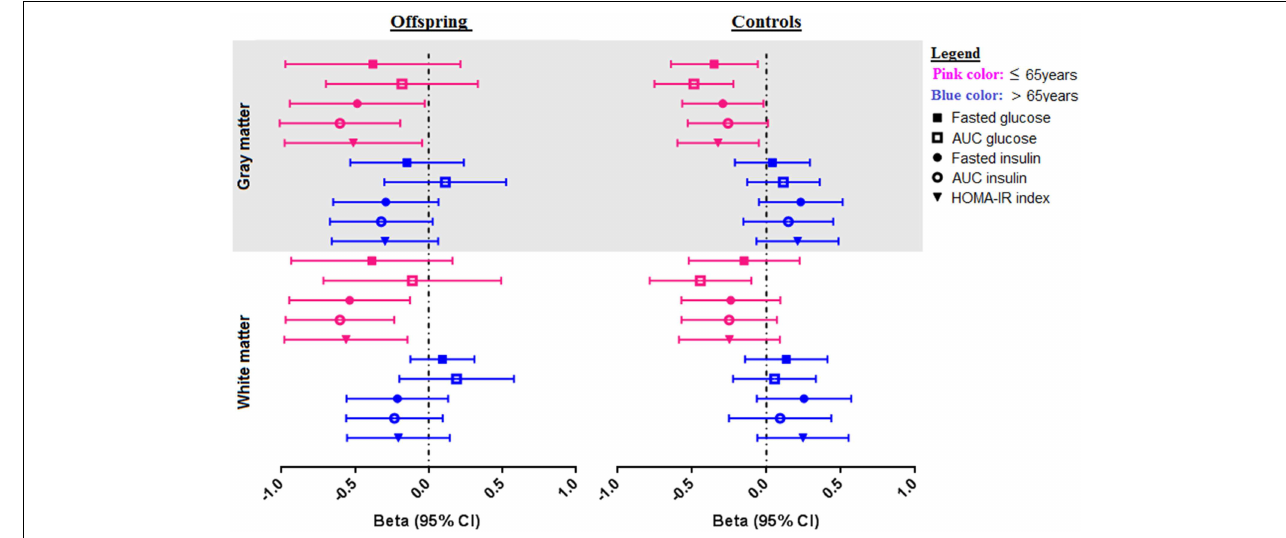
controls. The offspring and control groups were stratified into two age categories- ≤ 65 years old (shown in pink color), and > 65 years (shown in blue color). Associations are from linear regression analysis, correcting for age and sex. Associations are presented as standardized Beta coefficients with corresponding 95%